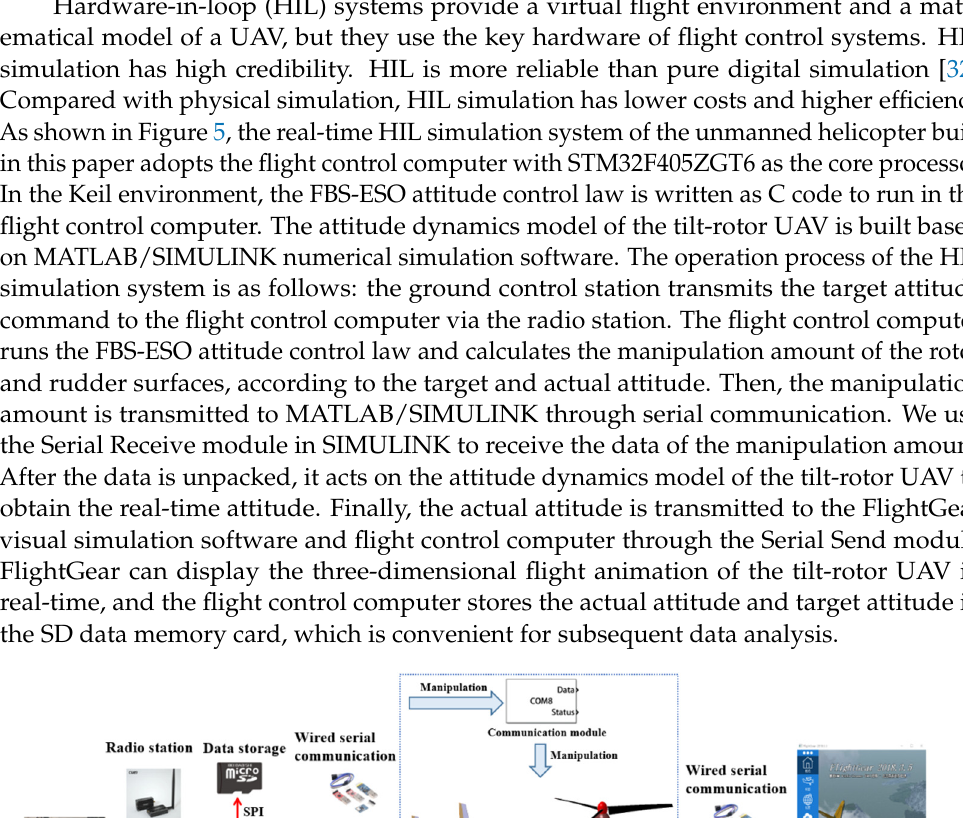
Figure 6. Schematic diagram of the tilt ‐ rotor UAV. Table 4. Parameters of the tilt ‐ rotor UAV.